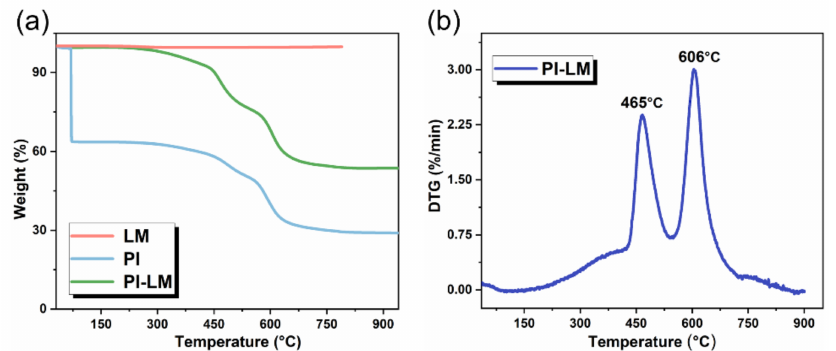
Figure 7. ( a ) The weight change of the prepared PI-LM film. ( b )The DTG plotting of the prepared PI-LM